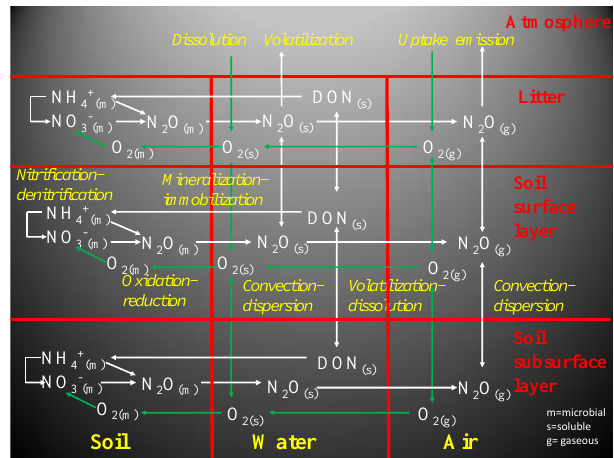
Figure 1. Summary of key processes governing generation and emission of N 2 O as represented in ecosys